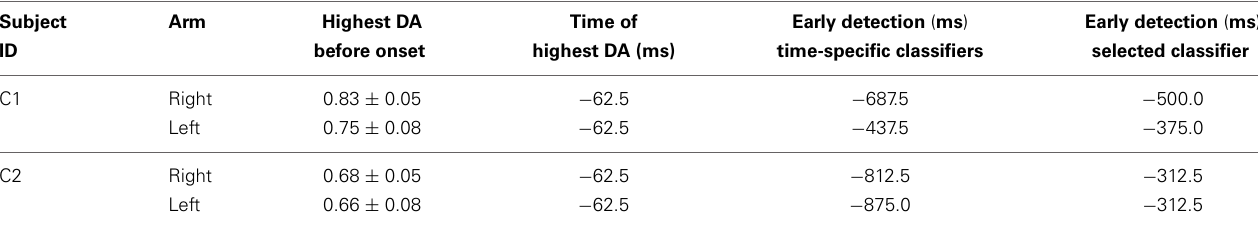
Table 2 | Summary of decoding performances before movement onset for able-bodied